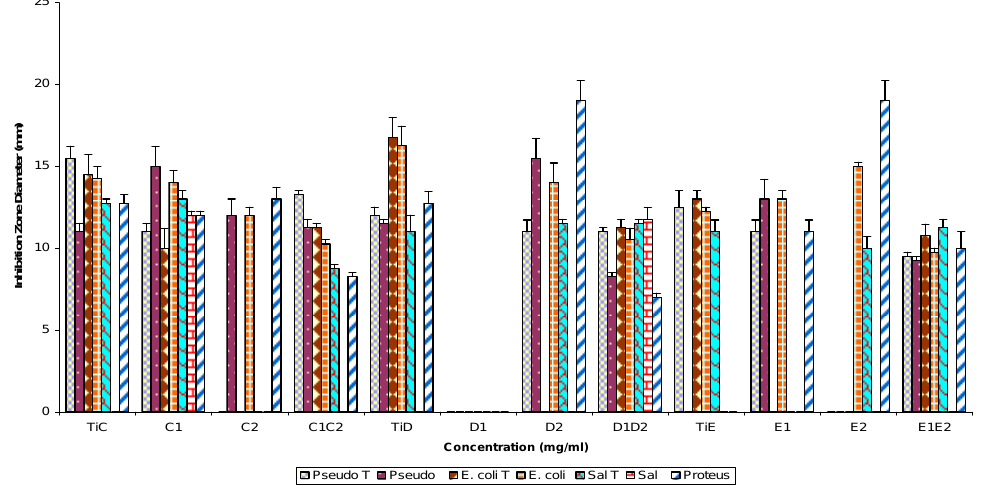
Figure 5. Antibacterial susceptibility pattern of Gram negative bacterial test strains to fraction TiC, TiD and TiE, refraction products singly and in